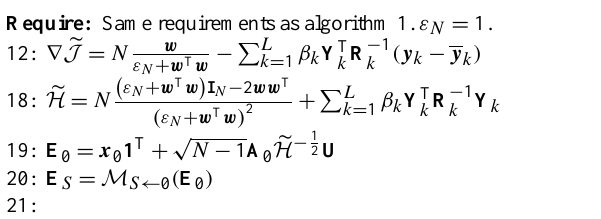
Fig. 4. Comparison of the filtering (left) and smoothing (right) performance of the SDA IEnKS, MDA IEnKS, the EnKS and 4D-Var, in non-linear conditions corresponding to ∆ t =0 . 20 .